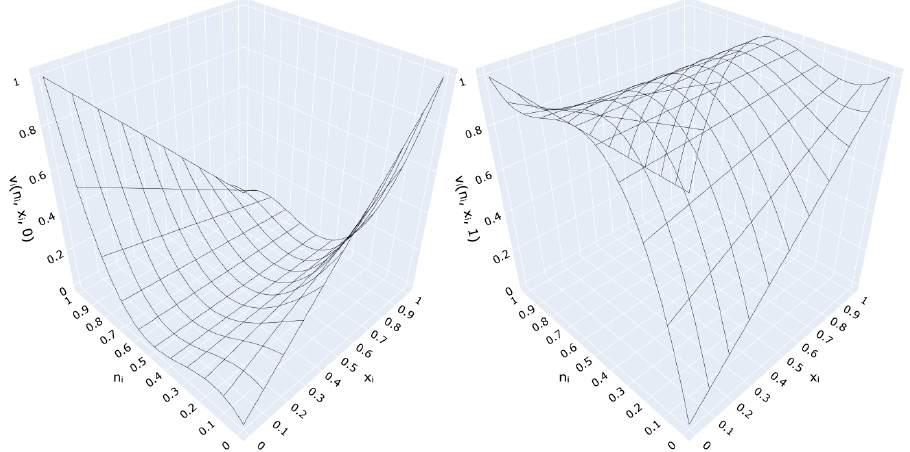
Figure 3. VCM transformation ( left ) z = 0 ( T -conorm neutral value); ( right ) z = 1 ( T -norm neutral